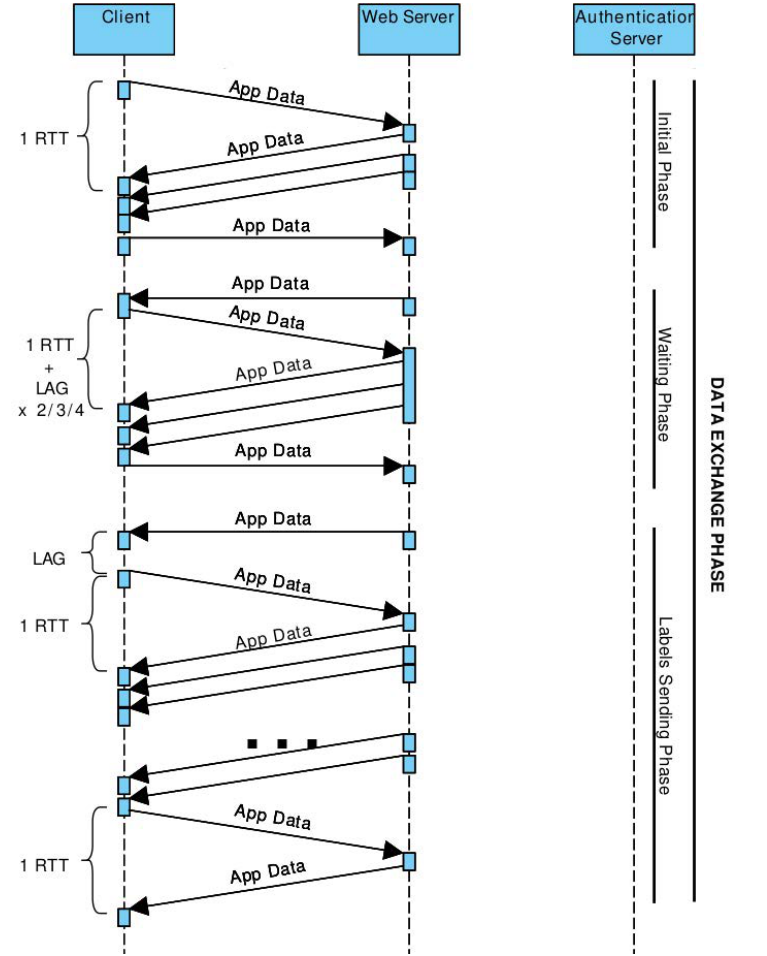
Figure 18. Sequence Diagram: API RTTs Analysis, data exchange